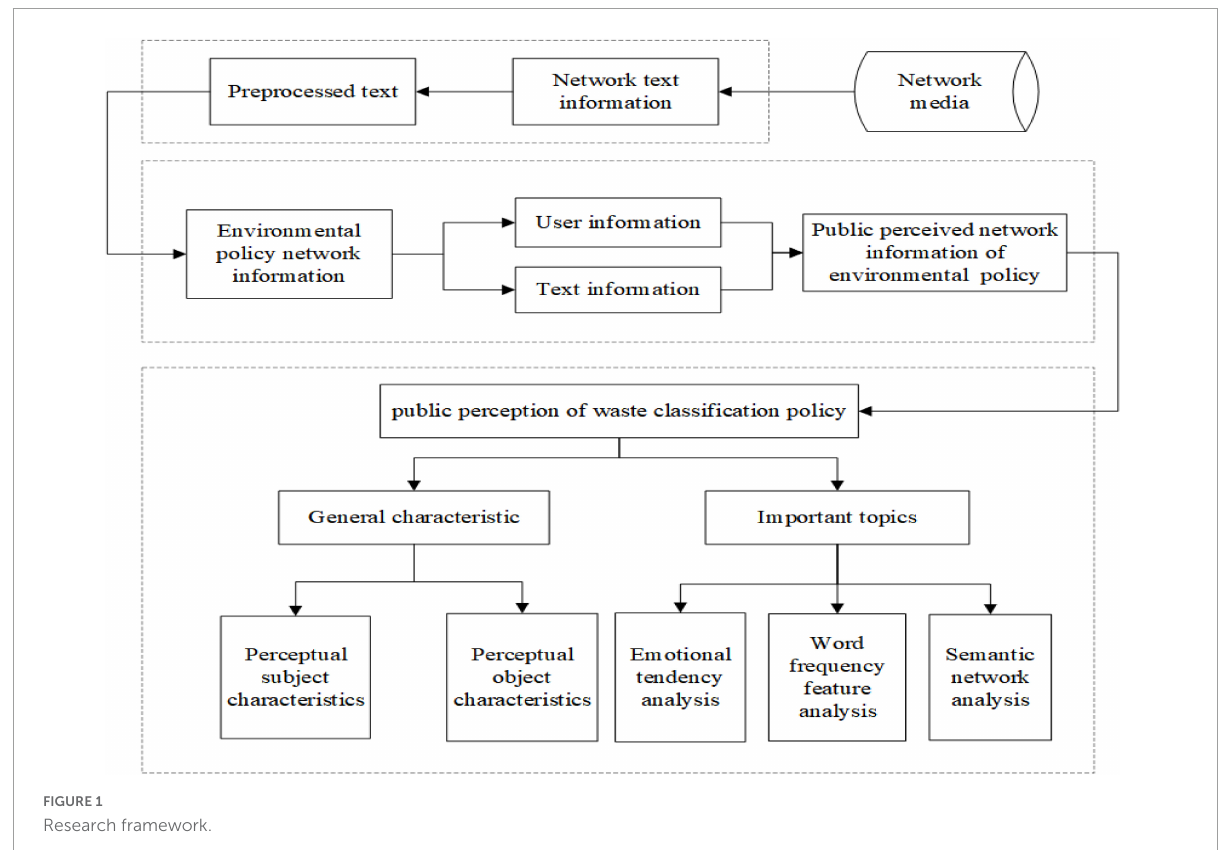
FIGURE1 Research framework.